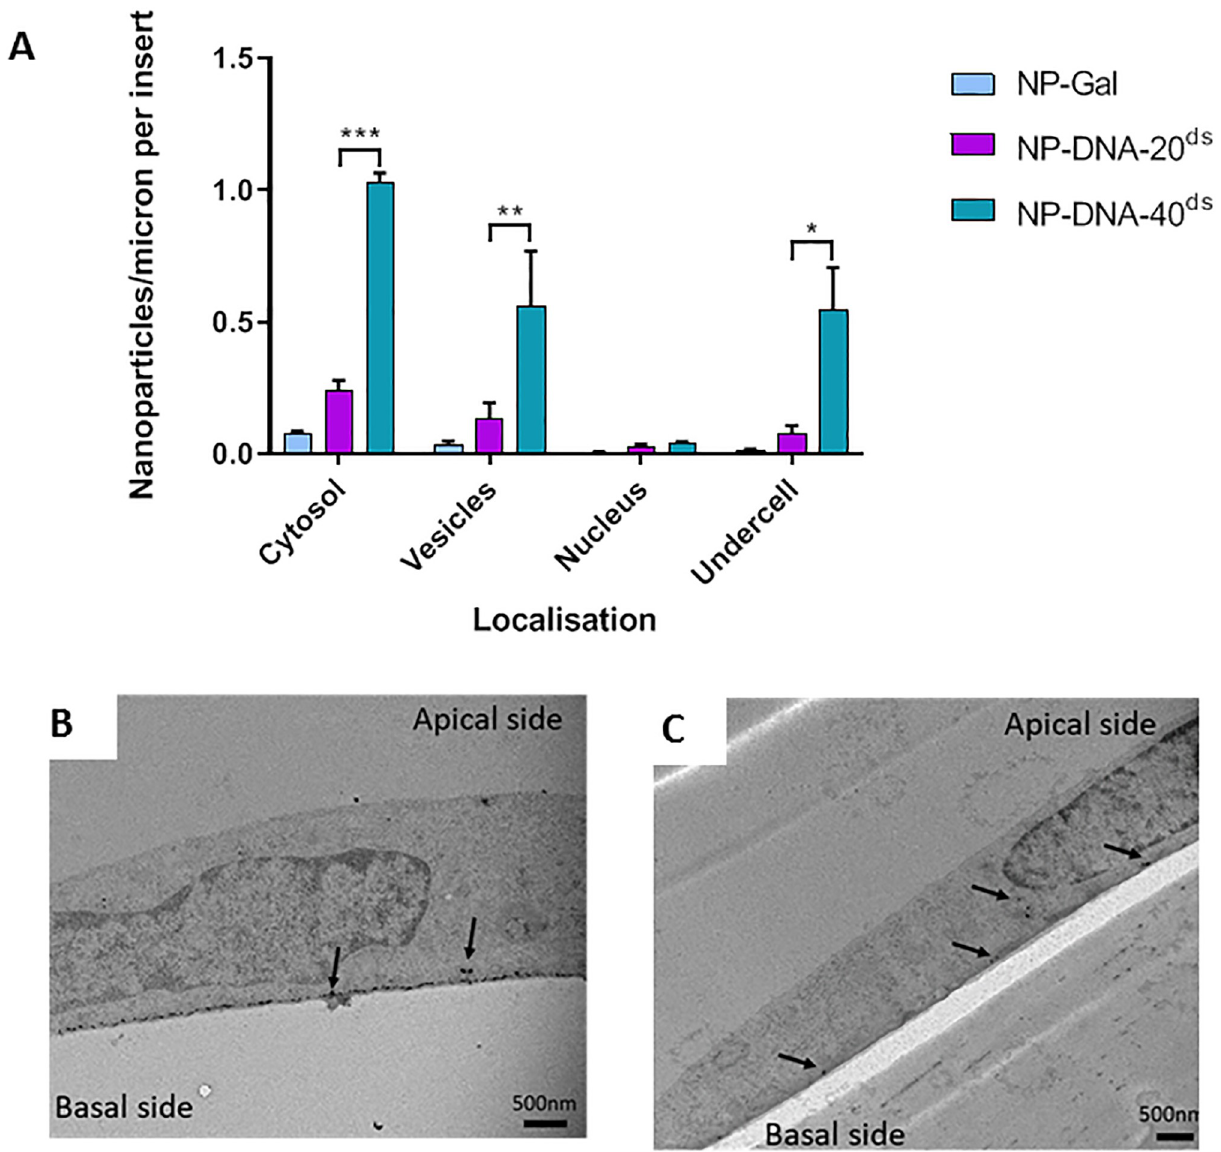
Fig 3. Endocytosis and transcytosis of nanocarriers with 20nt or 40nt dsDNA cargo. (A) Uptake of NP-DNA-20 ds and NP-DNA-40 ds into brain endothelial cells. Nanoparticles were quantified in the cytosol, vesicles, nucleus, and at the basal membrane (undercell). NP-Gal was the nanoparticle control, no DNA attached. Three experiments were performed, each experiment having three technical repeats. Tukey’s multiple comparisons test showed significant difference for NP-DNA-40 ds compared to NP-DNA-20 ds in cytosol ( ��� P = 0.0003), vesicles ( �� P = 0.0082) and under cell ( � P = 0.0108). (B) Electron micrographs of silver enhanced gold NPs in vesicles and at the basal membrane of hCMEC/D3 cells treated at the apical membrane (top) with NP-DNA-40 ds (A) or NP-DNA-20 ds .